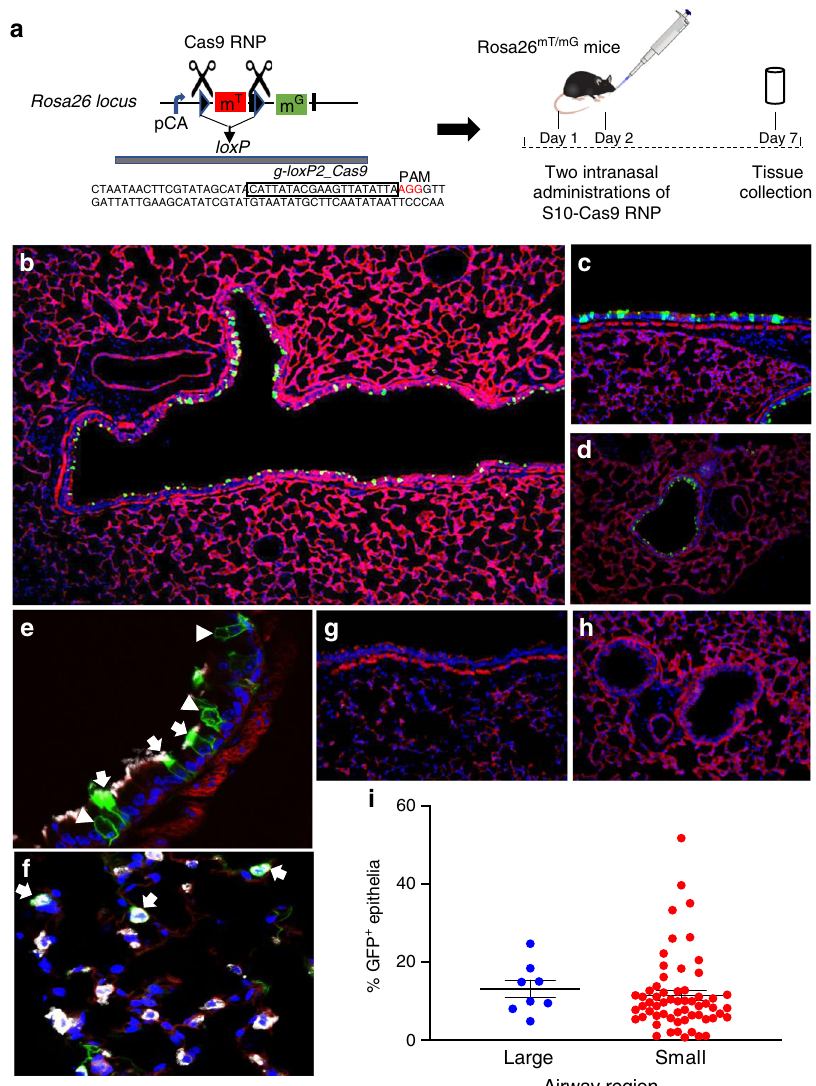
Fig. 4 S10 peptide delivery of Cas9 RNP shows editing in ROSA mT/mG locus in vivo. Cas9 RNP directed to loxP sites fl anking the tdTomato cassette were administered with S10 peptide once daily on 2 consecutive days. Seven days later, conversion of tdTomato to GFP expression was visualized in lung tissue sections. a Schematic of gRNA targeting two loxP sequences fl anking tdTomato gene and experimental protocol for Cas9 RNP delivery to ROSA mT/mG mice. b Fluorescence image of large airway 7 days following two intranasal doses of [S10]: 40 µ M; [Cas9]: 1.33 µ M; [gRNA]: 2 µ M; ×2 magni fi cation. GFP expression denotes edited cells. c Editing in a large airway, ×20 magni fi cation. d Editing in a small airway; ×20 magni fi cation. e Co-localization of GFP and marker of ciliated cells ( α -tubulin, white) in large airway. Arrows indicate α -tubulin co-localization with GFP. Arrowheads denote edited (GFP + ) non- ciliated cells negative for α -tubulin; ×40 magni fi cation. f Co-localization of GFP + and SP-C (white) identi fi es alveolar type II cells (arrows) in distal lung; ×40 magni fi cation. g Representative image of large airway after delivery of Cas9 RNP alone shows no editing, ×20 magni fi cation. h Representative image of small airways after delivery of Cas9 RNP alone shows no editing; ×20 magni fi cation. i Editing ef fi ciency of Cas9 in large and small airways quanti fi ed by the number of GFP + cells. Horizontal lines indicate mean ± SE; n = 5 mice/group. Data underlying this fi gure are provided as Source Data fi approach for hard-to-transduce cell types and may serve as a platform for further design opportunities with other cargoes including therapeutic antibodies and peptides.